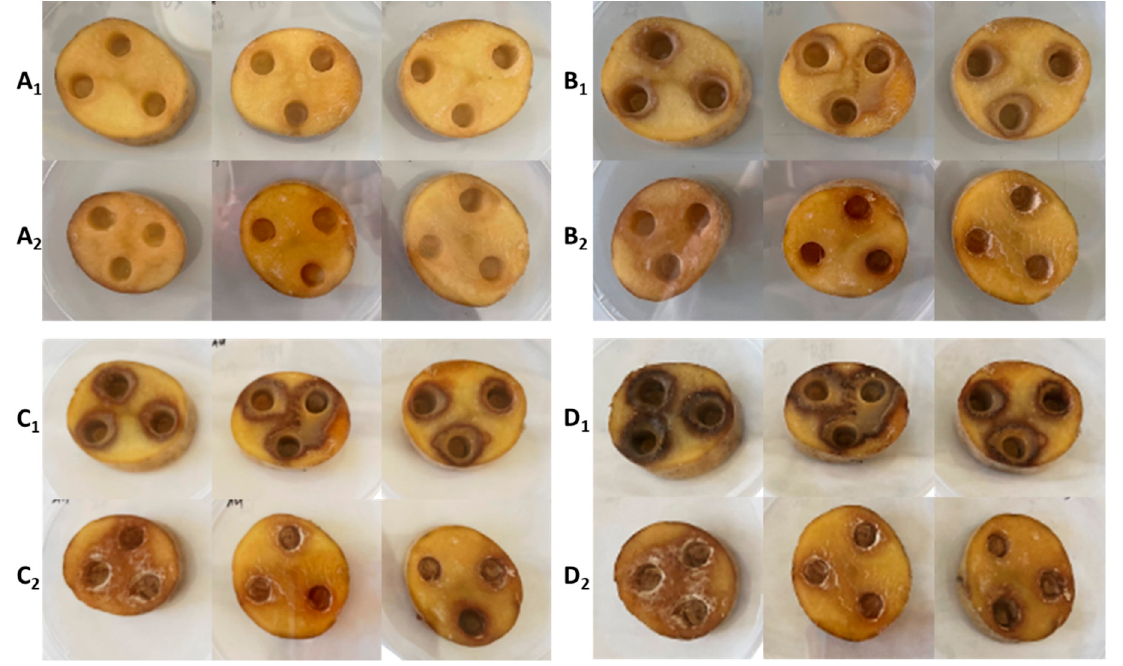
Figure 1. Development of P87 bacterial rot during 96 h at 25 °C on potato slices. ( A 1 ) control at 24 h; ( A 2 ) phage-treated at 24 h; ( B 1 ) control at 48 h; ( B 2 ) phage-treated at 48 h; ( C 1 ) control at 72 h; ( C 2 ) phage-treated at 72 h; ( D 1 ) control at 96 h; ( D 2 ) phage-treated at 96 h.